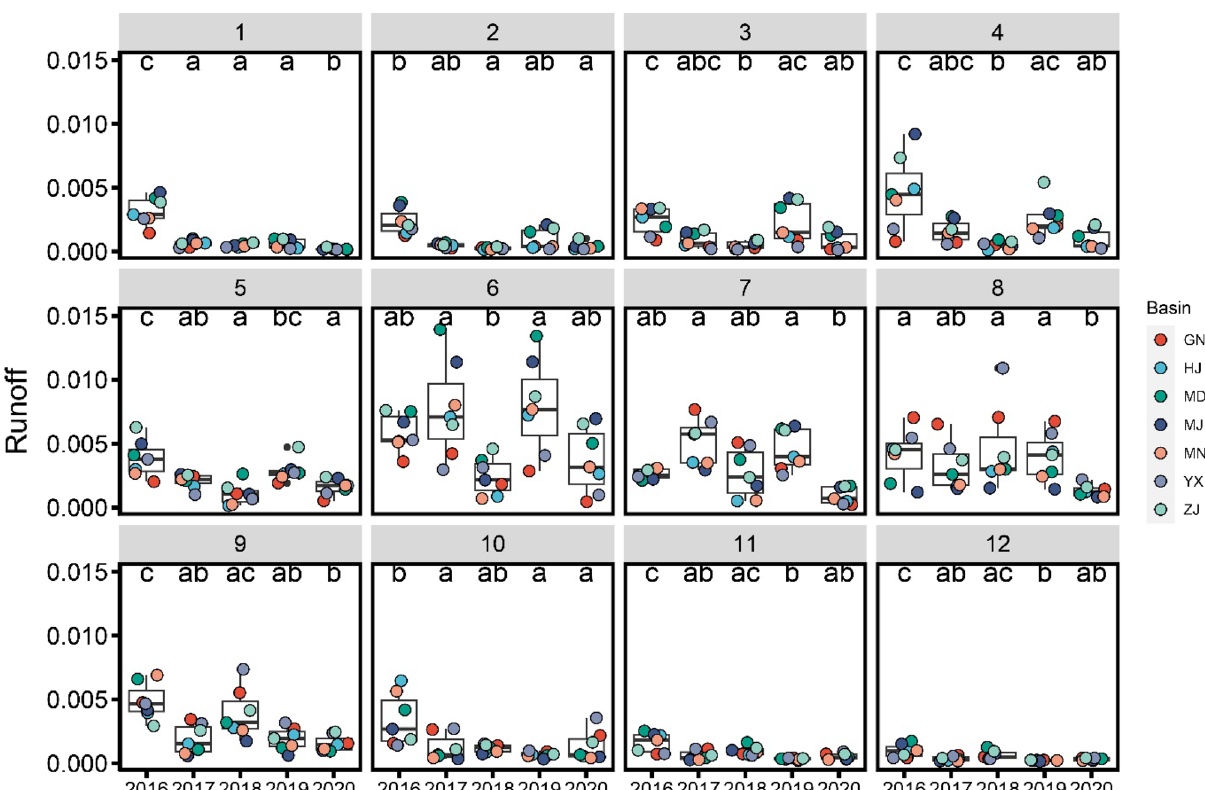
Figure 2. Average monthly runoff of the basins throughout coast of Southern China from January of 2016 to December of 2020. The 12 facets represent the months from January to December. Horizontal line in box: median value; bottom and top of box: 25th and 75th percentiles; whiskers: 5th and 95th